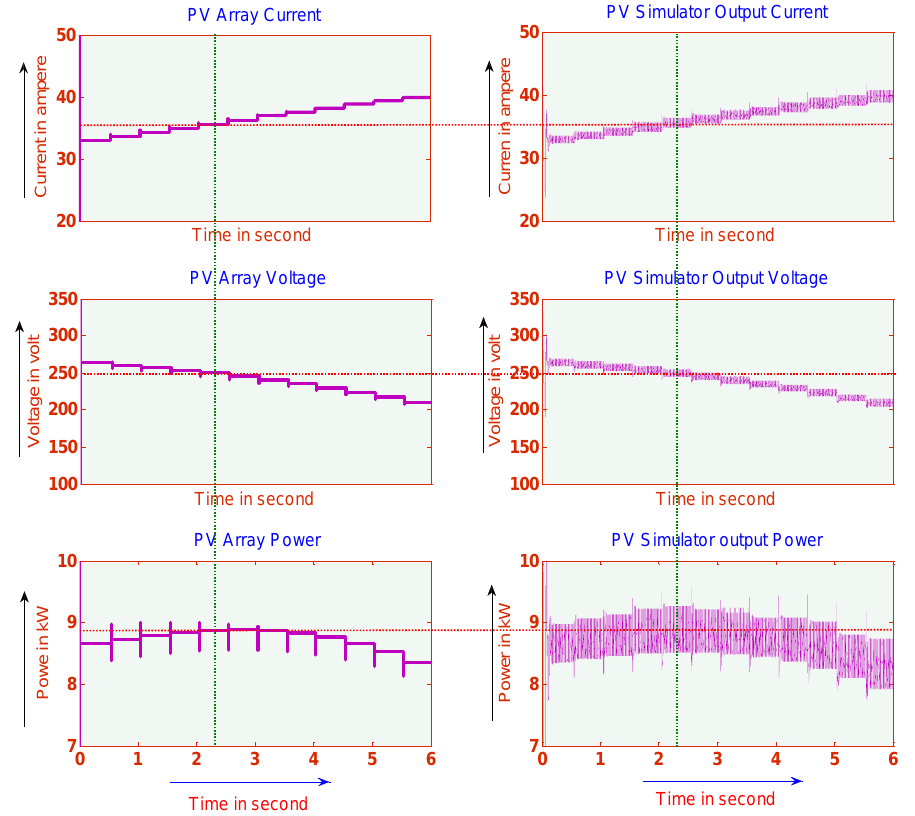
Figure 8. Output Voltage, Current and Powers from an Actual PV array and the PV-Simulator for at an Irradiance of 600 W/Sq.m.